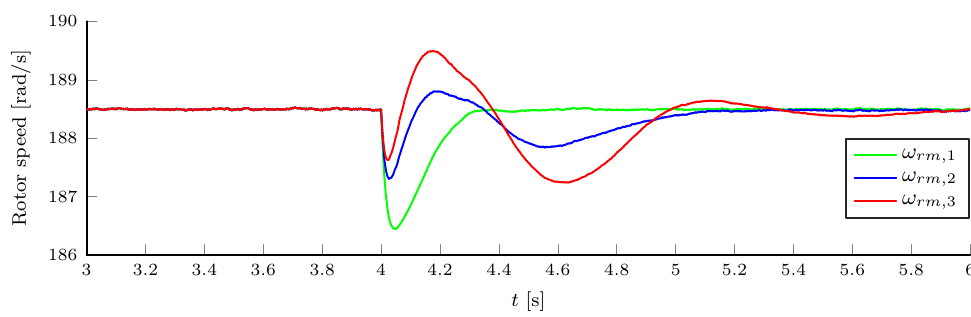
Figure 21. Mechanical rotor velocities (zoomed in); current-source control. Figure 20 shows the mechanical rotor speed for all motors including the initial start-up period; Figure 21 provides a zoomed-in view of the response after the unequal torque loads are applied at t = 4 s. As shown in Figure 21, the transient rotor response resolves in approximately 2 s. All IM rotor speeds reached approximately 188.5 rad/s in the steady-state; close speed tracking (compared to the previous case study) was a result of the closed-loop speed control used in this study (see Figure 8).